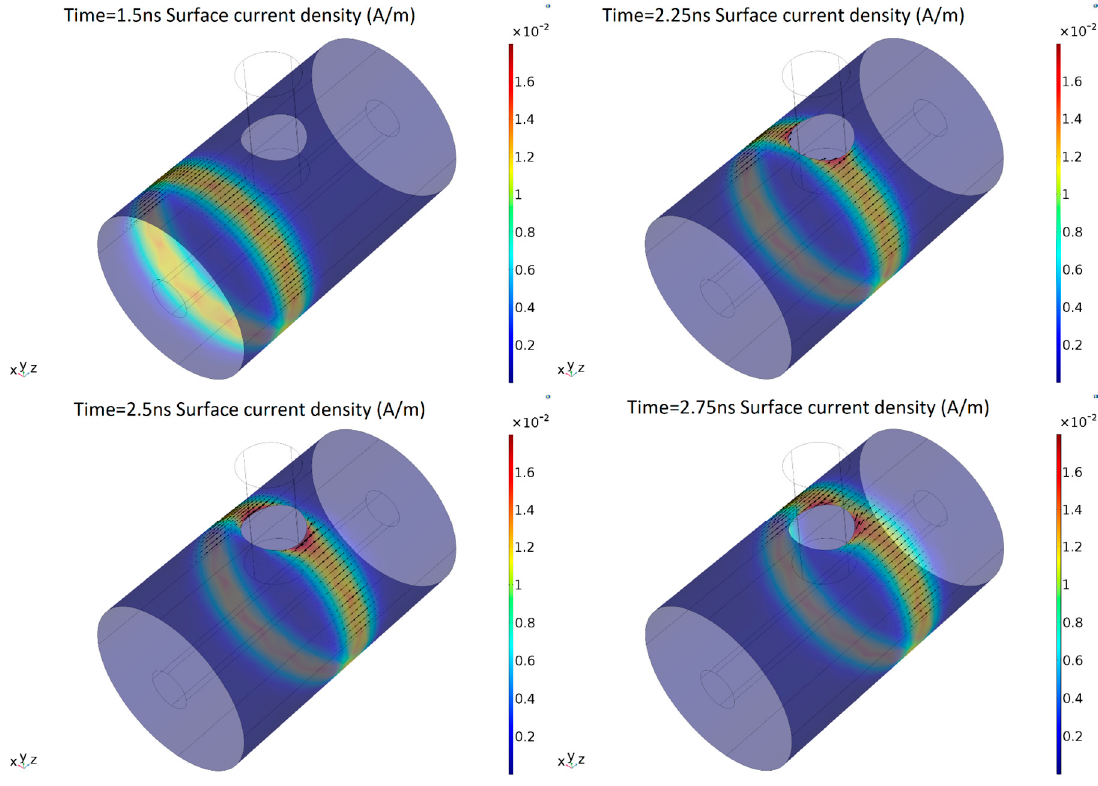
Figure 5. Surface current temporal evolution.